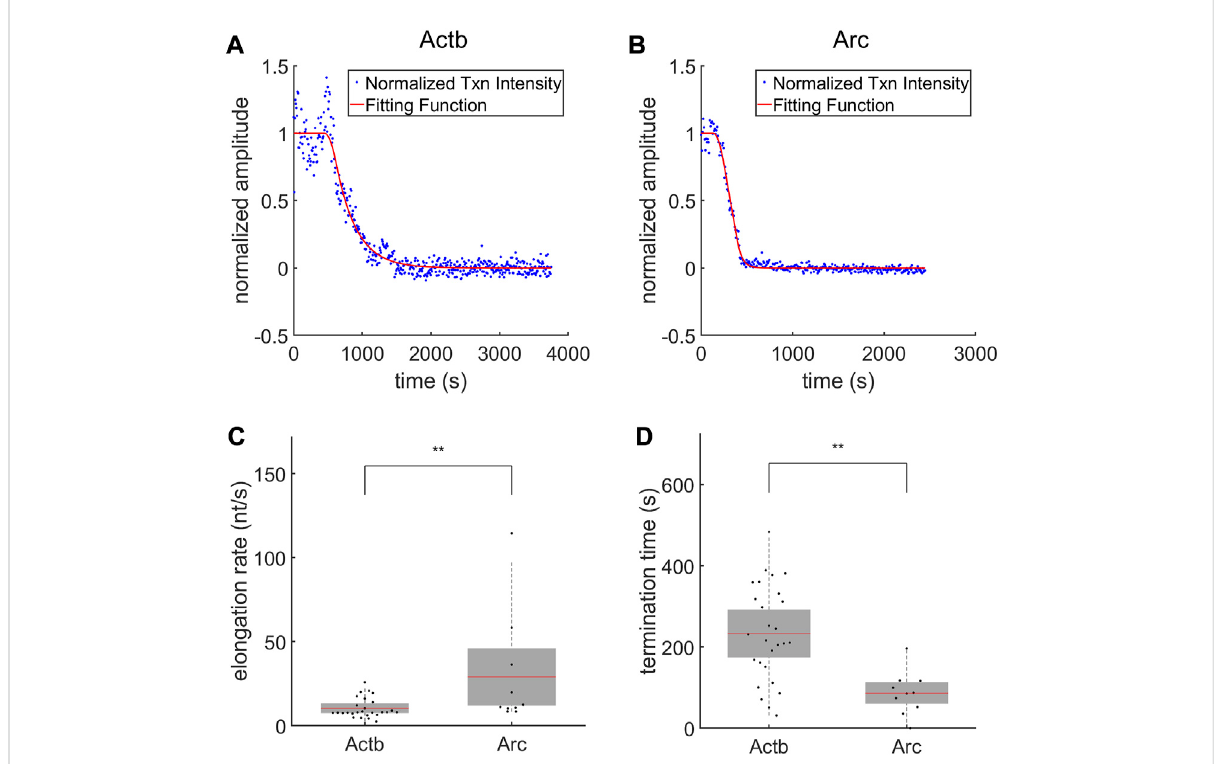
FIGURE 3 Time-resolved analysis of Actb and Arc transcription. (A,B) Representative transcription intensity data (blue dots) and the best fi t curves (red lines) of Actb (A) and Arc (B) after the addition of triptolide at t (cid:2) 0. (C,D) The elongation rates (C) and termination times (D) of Actb (n = 27 transcription sites) and Arc (n = 10 transcription sites). The mean (red line) and standard deviation (SD, gray box) values are indicated (** P < 0 . 01, Wilcoxon rank-sum